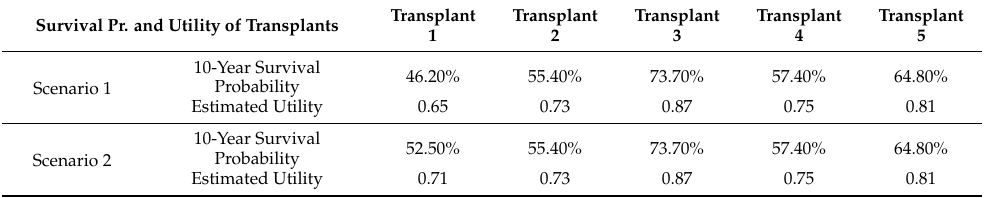
Table 3. Survival probability and utility of transplants in the chain in scenarios 1 and 2.